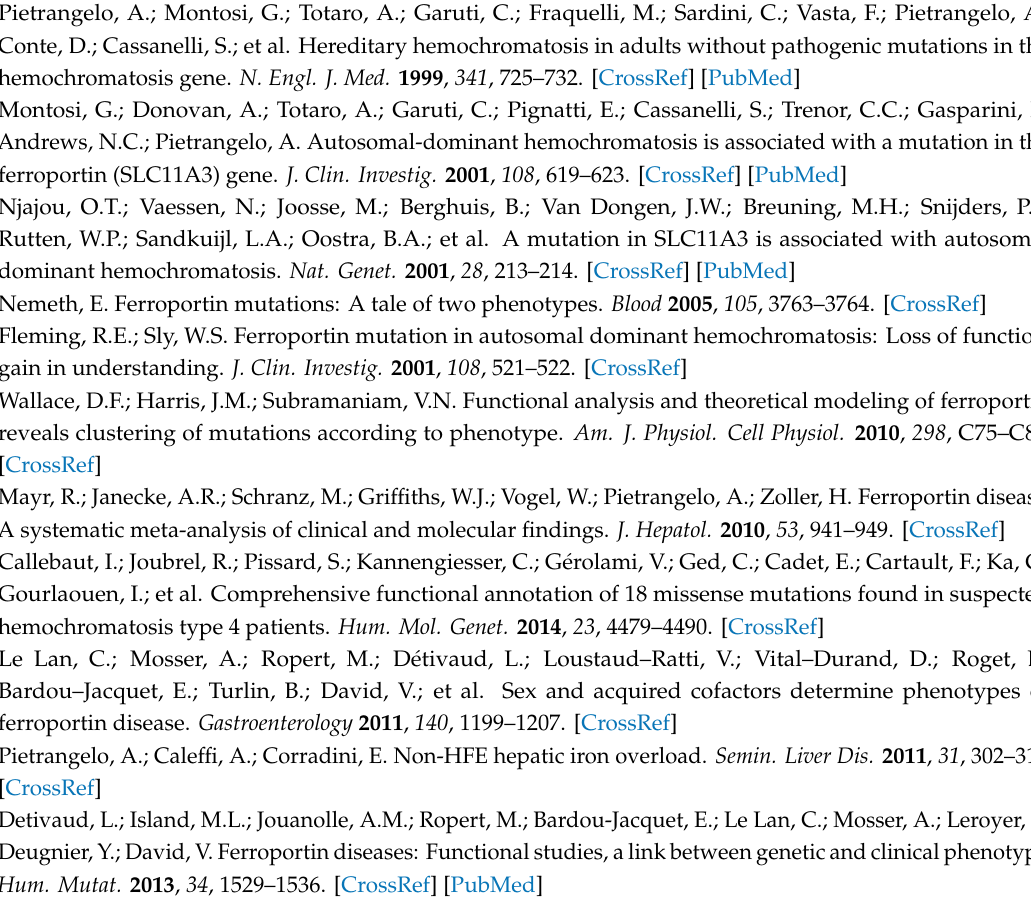
Figure 1S: Relation between age and serum iron / TSAT / ferritin, Table 1S: Characteristics and iron parameters of probands versus probands’ relatives, Table 2S: Phenotypical features by the reported presence of hereditary HFE and non-HFE iron overload conditions, Table 3S: Phenotypical features by the reported current use of alcohol, Table 4S: Phenotypical features of patients with functional LOF ferroportin variant by hepcidin sensitivity, Table 5S: Phenotypical features by hepcidin resistant GOF and LOF ferroportin